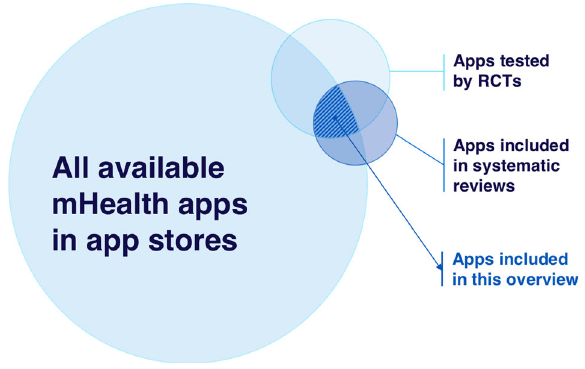
Fig. 2 Scope of the